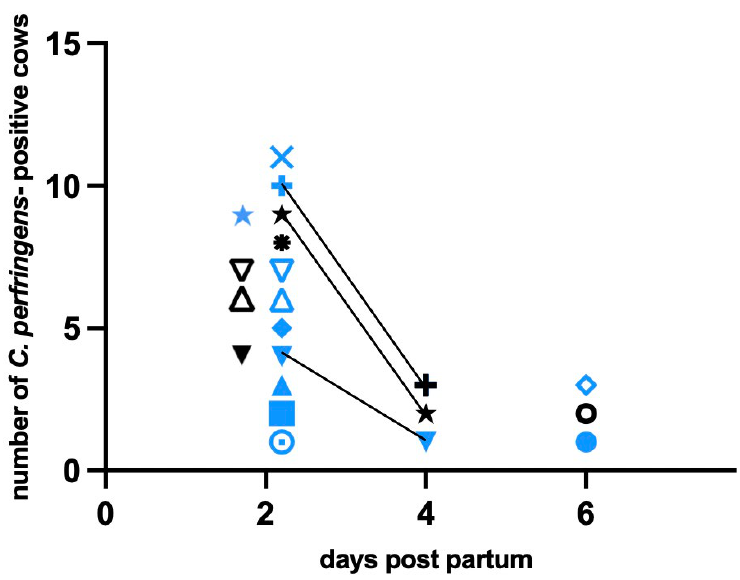
Figure 1. Visualization of the distribution of C. perfringens isolates ( n = 21) among the hosts ( n = 14) in relation to the time of sampling and the localization; each symbol stands for an isolate, different symbols symbolize the cows, different colors symbolize the localization; black = vagina, blue = uterus, line = follow-up isolate. Table 5. Minimum inhibitory concentration (MIC) range, MIC 50 , MIC 90 , CLSI- breakpoint